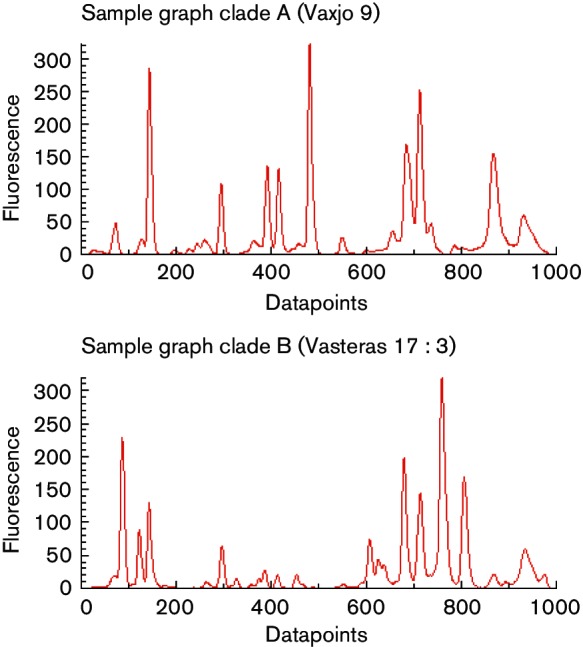
Examples of graphs of isolates belonging to clade A and B. Clade A is represented by the clinically significant isolate Vaxjo_9 and clade B is represented by the environmental isolate Vasteras 17 : 3.